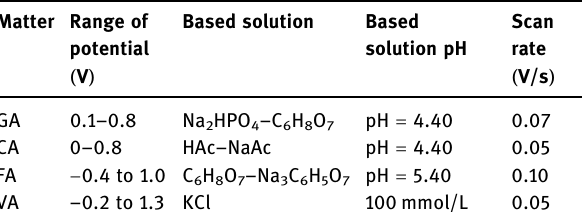
Table 1: The optimum condition of the CV curve of four polyphenolic compounds